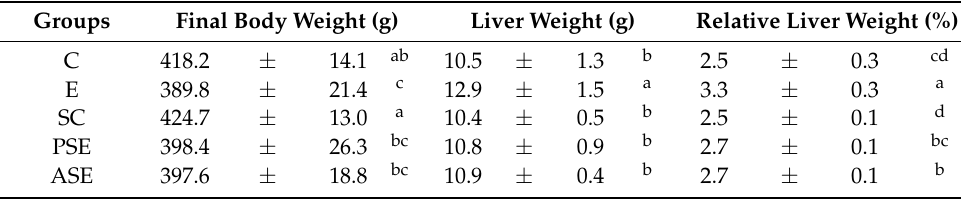
Table 2. Effects of synbiotics supplementation on body weight (BW) and liver weight in rats with chronic ethanol feeding 1 .